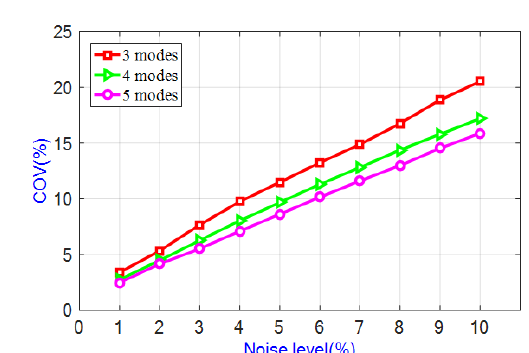
Fig. 6. Coe(cid:30)cients of variances for damaged element 1 in scenario A with three di(cid:27)erent damage degrees (10%, 20% and 30%).